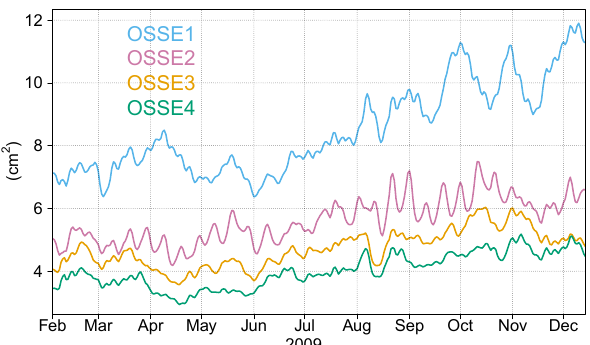
Figure 4. The temporal evolution of the SSH error variance in the ocean analysis over the period from February to December 2009. Results obtained by comparing the SSH of the ocean analysis in the OSSE1 (blue line), OSSE2 (purple line), OSSE3 (orange line) and OSSE4 (green line) experiments with the data from the NR considering the ocean areas with a bathymetry deeper than 200m. OSSE0 (not shown) ranged between 25 and 35cm 2 .